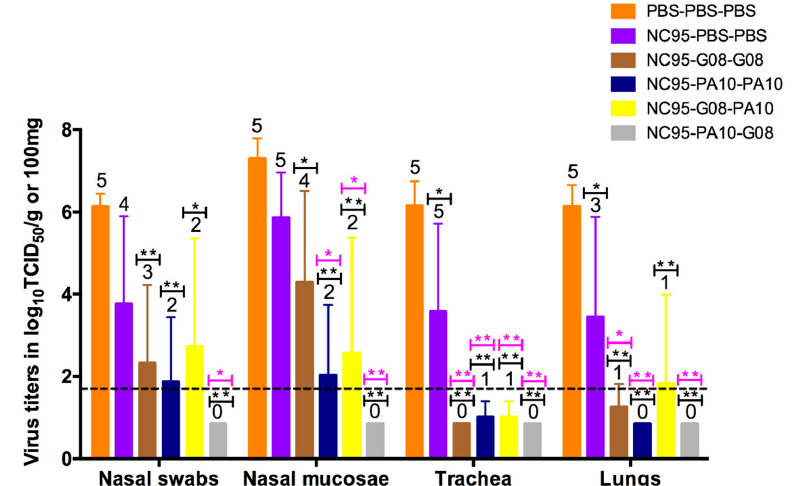
Figure 2. Virus titers in nasal swabs, nasal mucosa, trachea, and lungs, 3 days after challenge with 10 7 TCID 50 of MO15. The bars represent mean virus titers ± SD. The dotted line indicates the detection limit. Each color of the bar represents a different vaccine group as shown by the legend at the top right corner. The numbers above the bars indicate the number of pigs with detectable virus titers. Significant reductions of virus titers as compared with the naïve challenge control group (PBS-PBS-PBS, black asterisks) and infection-immune challenge control group (NC95-PBS-PBS, pink asterisks) in ANOVA are shown above the bars. * p < 0.05, ** p < 0.01.